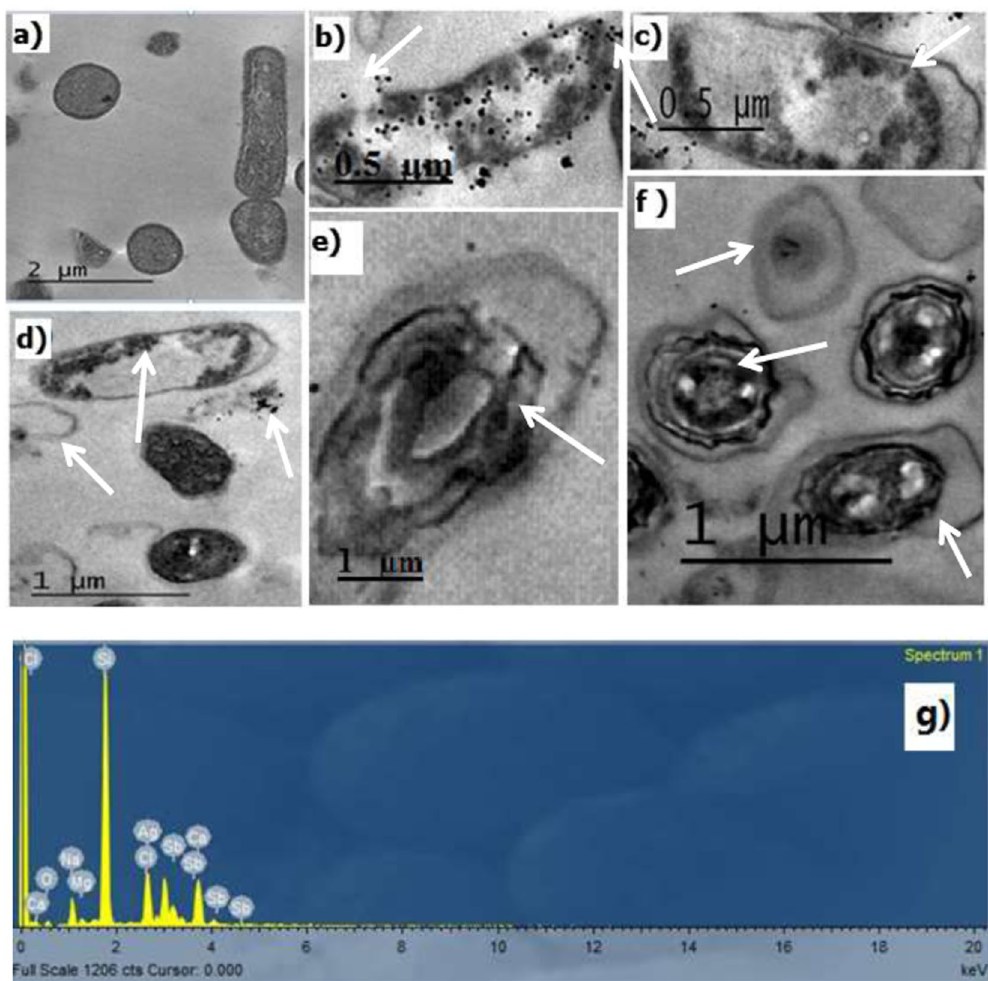
Figure 8. TEM morphological changes of B. cereus as cell structure with or without O-AgNPs. ( a ) Structure of intact cell (control), ( b ) damaged cell membrane and releasing of cytoplasm, ( c , d ) dark mineral particles and electron dense particles within cytoplasm, ( d , f ) cellular disintegration and ( e , f ) shrinking of protoplasm and detachment of cellular membrane (cellular deformation). ( g ) EDX spectrum of B. cereus cells with O-AgNPs.